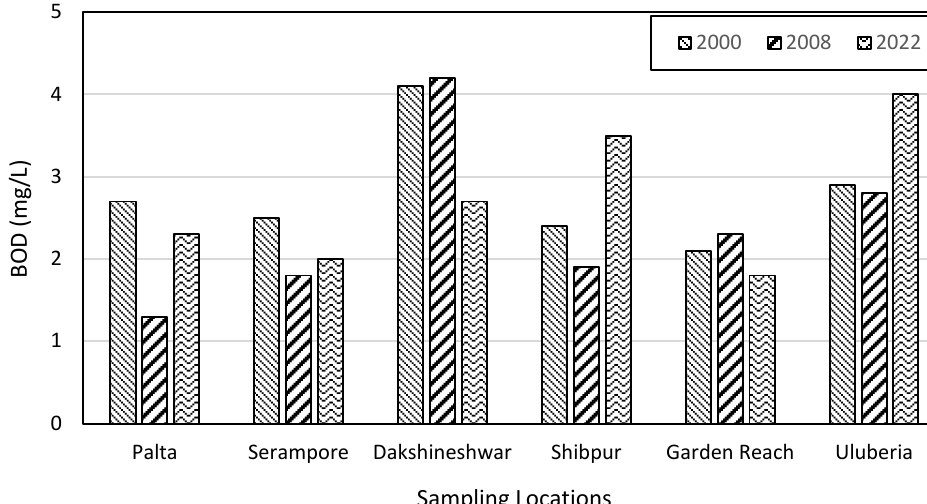
Figure 11. Variation of BOD in different locations.